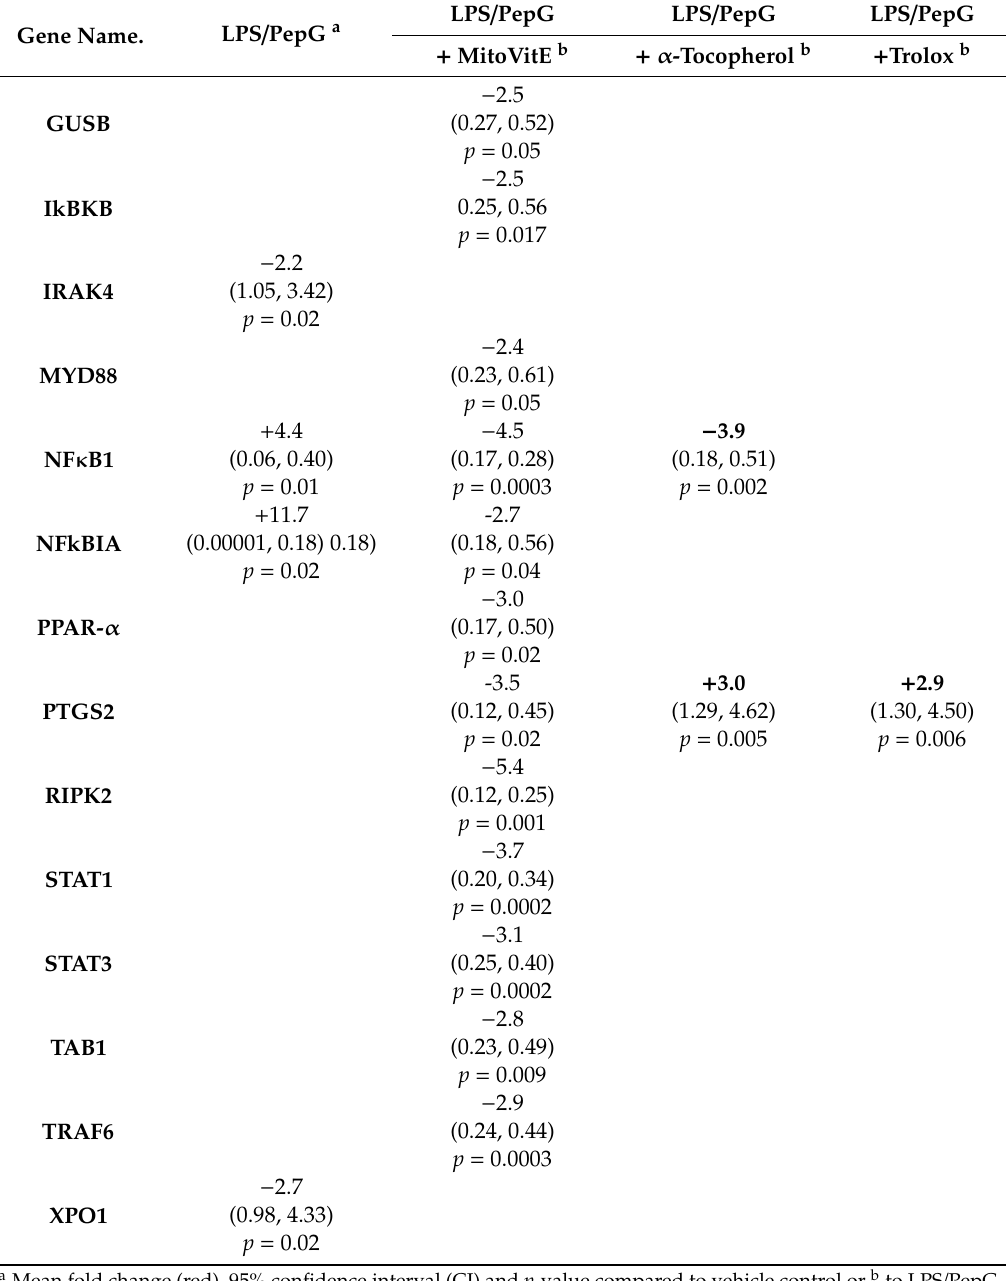
Table 1. Di ff erential gene